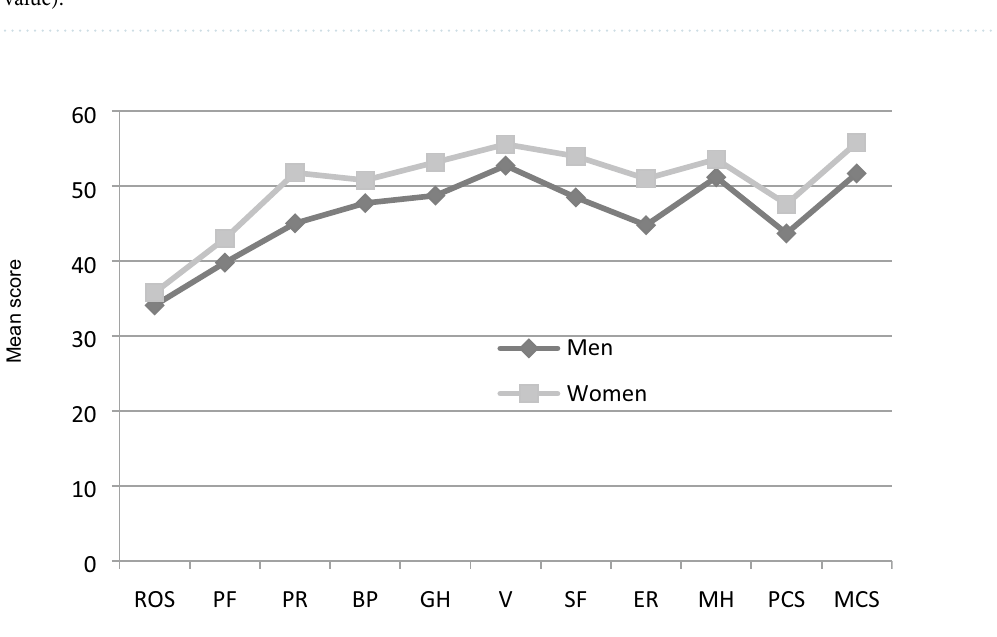
Figure 4. Rosenberg questionnaire, SF36 questionnaire (mean ±